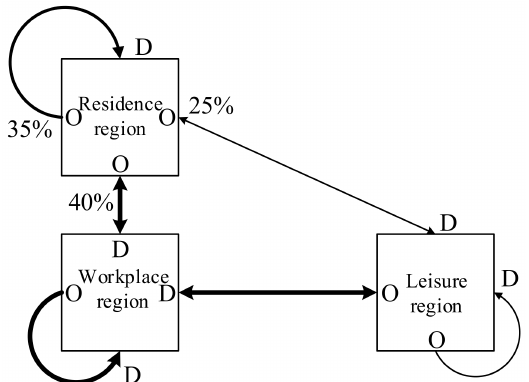
Figure 3. Illustration of interactions between functional regions based on taxi O/D flows in a particular time